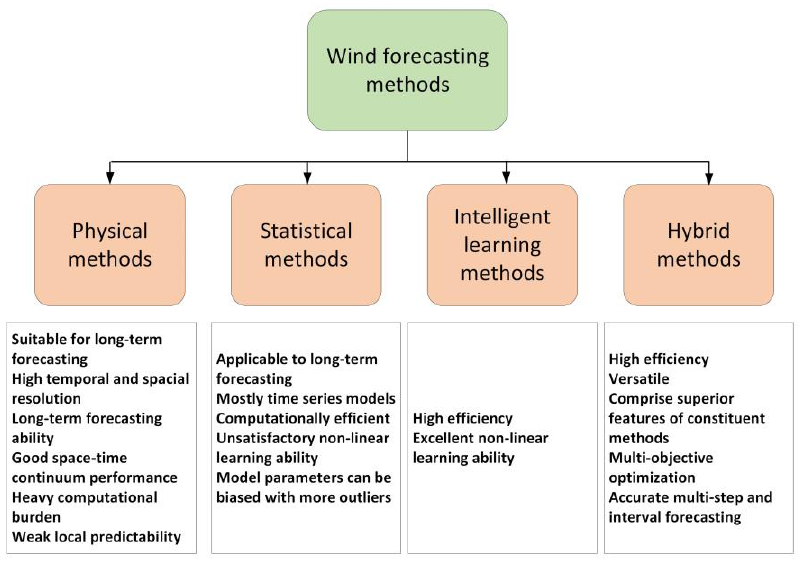
Figure 4. Wind forecasting methods.